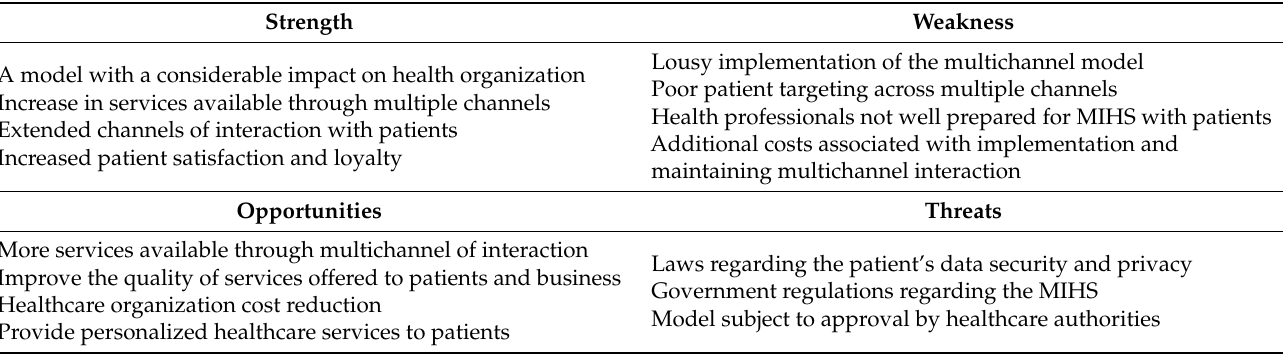
Table 3. SWOT analysis of the model of